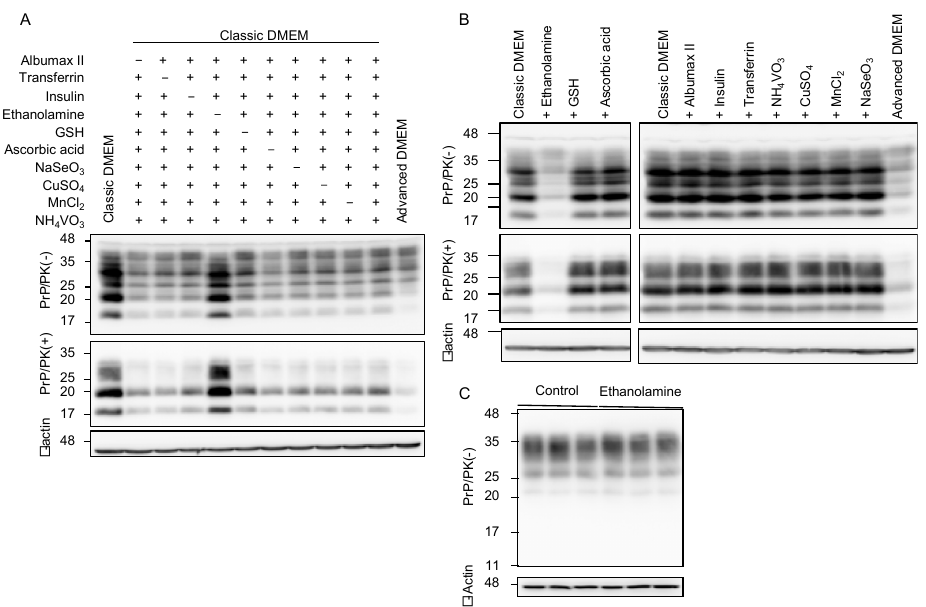
Figure 2. Ethanolamine reduces PrP Sc levels in prion-infected cells. ( A ) Western blotting with 6D11 anti-PrP antibody of PK-treated or -untreated cell lysates from N2aC24L1-3 cells cultured in classic DMEM supplemented with various combinations of indicated compounds for 8 days. β -actin is an internal control. Ethanolamine, 1.9 mg/L (31 μ M); GSH, 1 mg/L; ascorbic acid phosphate, 2.5 mg/L; recombinant insulin, 10 mg/L; human transferrin (holo), 7.5 mg/L; AlbuMAX II, 400 mg/L; Na 2 SeO 3 , 0.005 mg/L; NH 4 VO 3 , 0.0003 mg/L; CuSO 4 , 0.00125 mg/L; MnCl 2 , 0.00005 mg/L. ( B ) Western blotting with 6D11 anti-PrP antibody of PK-treated or -untreated cell lysates from N2aC24L1-3 cells cultured in classic DMEM supplemented with various combinations of indicated